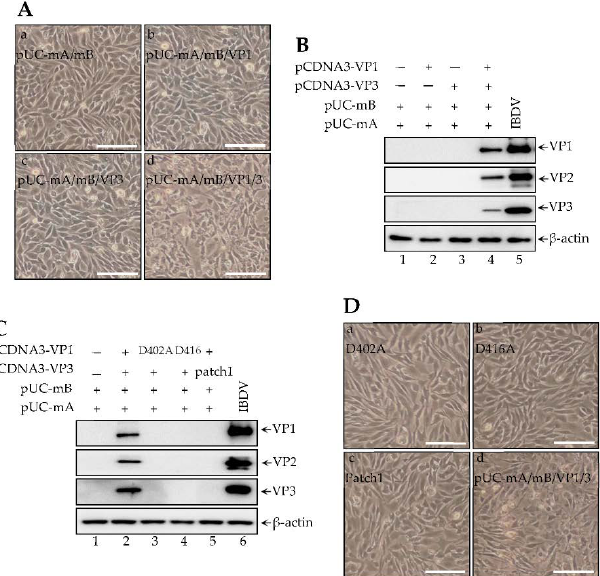
Figure 2. VP1 and VP3 are required for producing infectious IBDV. ( A ) Indicated plasmids were transfected into 293T cells for 72 h. Freeze thawed twice of the supernatant, which was further transferred into fresh DF-1 cells for culturing for another 48 h. A cytopathogenic effect was observed and taken imaged under the phase-phage microscopy. Scale bars, 100 µ m. ( B ) Supernatant of DF-1 cells incubated with indicated supernatant of transfected 293T cells were further transferred into fresh DF-1 cells for culturing another 24 h. The cell lysates were subjected to western blot using VP1–VP3 antibodies. ( C ) Transfected 293T cells were subjected to western blot using VP1–VP3 antibodies. ( D ) Indicated plasmids were transfected into 293T cells for 72 h. Freeze thawed twice of the supernatant, which was further transferred into fresh DF-1 cells for culturing for another 48 h. A cytopathogenic effect was observed and taken imaged under the phase-phage microscopy. Scale bars, 100 µ